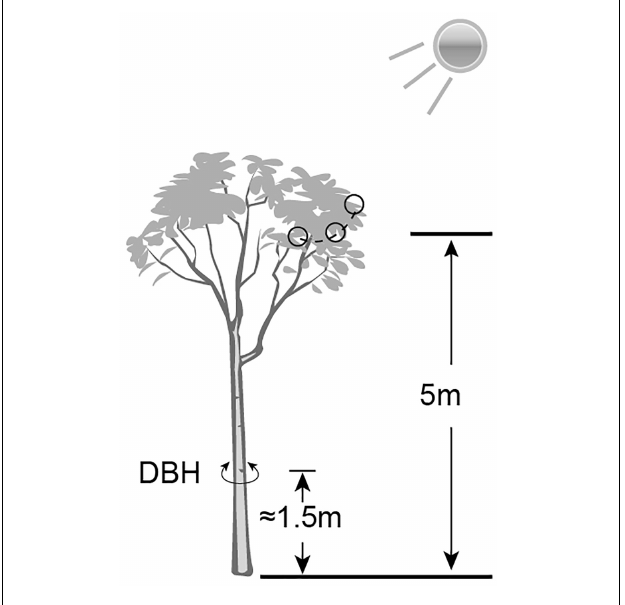
FIGURE 1 | A schematic diagram of sample collection and data measurement. Small black circles indicated the sampling sites.